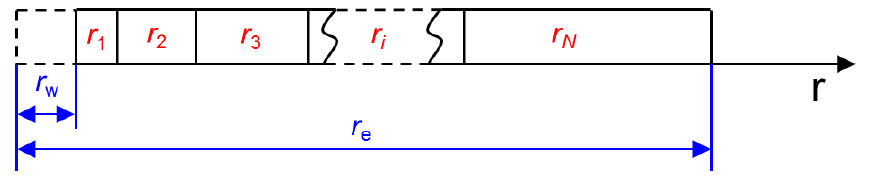
Figure 3. Schematic diagram of grid discretization.